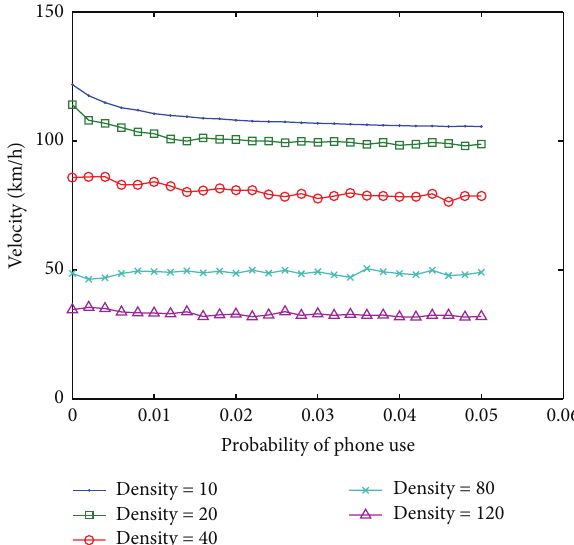
Figure 6: The change of velocity under different density.